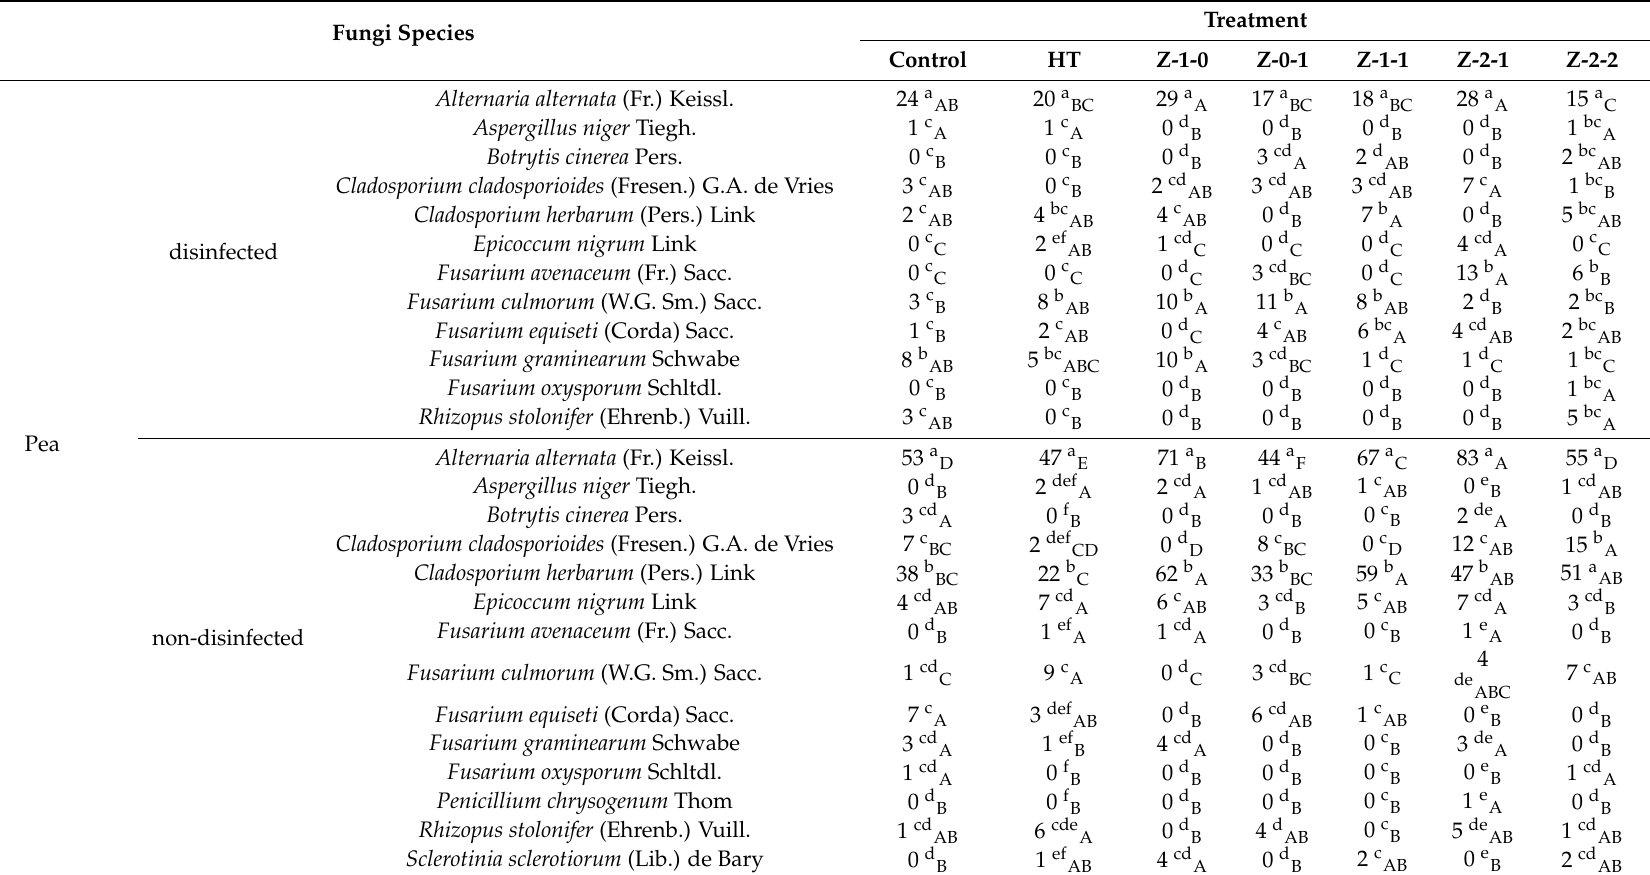
Table A1. Cont. Treatment Fungi Species Control HT Z-1-0 Z-0-1 Z-1-1 Z-2-1 Z-2-2 Alternaria alternata (Fr.) Keissl. 24 a AB 20 a BC 29 a A 17 a BC 18 a BC 28 a A 15 a C Aspergillus niger Tiegh. 1 c A 1 c A 0 d B 0 d B 0 d B 0 d B 1 bc A Botrytis cinerea Pers. 0 c B 0 c B 0 d B 3 cd A 2 d AB 0 d B 2 bc AB Cladosporium cladosporioides (Fresen.) G.A. de Vries 3 c AB 0 c B 2 cd AB 3 cd AB 3 cd AB 7 c A 1 bc B Cladosporium herbarum (Pers.) Link 2 c AB 4 bc AB 4 c AB 0 d B 7 b A 0 d B 5 bc AB Epicoccum nigrum Link 0 c C 2 ef AB 1 cd C 0 d C 0 d C 4 cd A 0 c C disinfected Fusarium avenaceum (Fr.) Sacc. 0 c C 0 c C 0 d C 3 cd BC 0 d C 13 b A 6 b B Fusarium culmorum (W.G. Sm.) Sacc. 3 c B 8 b AB 10 b A 11 b A 8 b AB 2 d B 2 bc B Fusarium equiseti (Corda) Sacc. 1 c B 2 c AB 0 d C 4 c AB 6 bc A 4 cd AB 2 bc AB Fusarium graminearum Schwabe 8 b AB 5 bc ABC 10 b A 3 cd BC 1 d C 1 d C 1 bc C Fusarium oxysporum Schltdl. 0 c B 0 c B 0 d B 0 d B 0 d B 0 d B 1 bc A Rhizopus stolonifer (Ehrenb.) Vuill. 3 c AB 0 c B 0 d B 0 d B 0 d B 0 d B 5 bc A Pea Alternaria alternata (Fr.) Keissl. 53 a D 47 a E 71 a B 44 a F 67 a C 83 a A 55 a D Aspergillus niger Tiegh. 0 d B 2 def A 2 cd A 1 cd AB 1 c AB 0 e B 1 cd AB Botrytis cinerea Pers. 3 cd A 0 f B 0 d B 0 d B 0 c B 2 de A 0 d B Cladosporium cladosporioides (Fresen.) G.A. de Vries 7 c BC 2 def CD 0 d D 8 c BC 0 c D 12 c AB 15 b A Cladosporium herbarum (Pers.) Link 38 b BC 22 b C 62 b A 33 b BC 59 b A 47 b AB 51 a AB Epicoccum nigrum Link 4 cd AB 7 cd A 6 c AB 3 cd B 5 c AB 7 cd A 3 cd B Fusarium avenaceum (Fr.) Sacc. 0 d B 1 ef A 1 cd A 0 d B 0 c B 1 e A 0 d B non-disinfected 4 Fusarium culmorum (W.G. Sm.) Sacc. 1 cd C 9 c A 0 d C 3 cd BC 1 c C 7 c AB de ABC Fusarium equiseti (Corda) Sacc. 7 c A 3 def AB 0 d B 6 cd AB 1 c AB 0 e B 0 d B Fusarium graminearum Schwabe 3 cd A 1 ef B 4 cd A 0 d B 0 c B 3 de A 0 d B Fusarium oxysporum Schltdl. 1 cd A 0 f B 0 d B 0 d B 0 c B 0 e B 1 cd A Penicillium chrysogenum